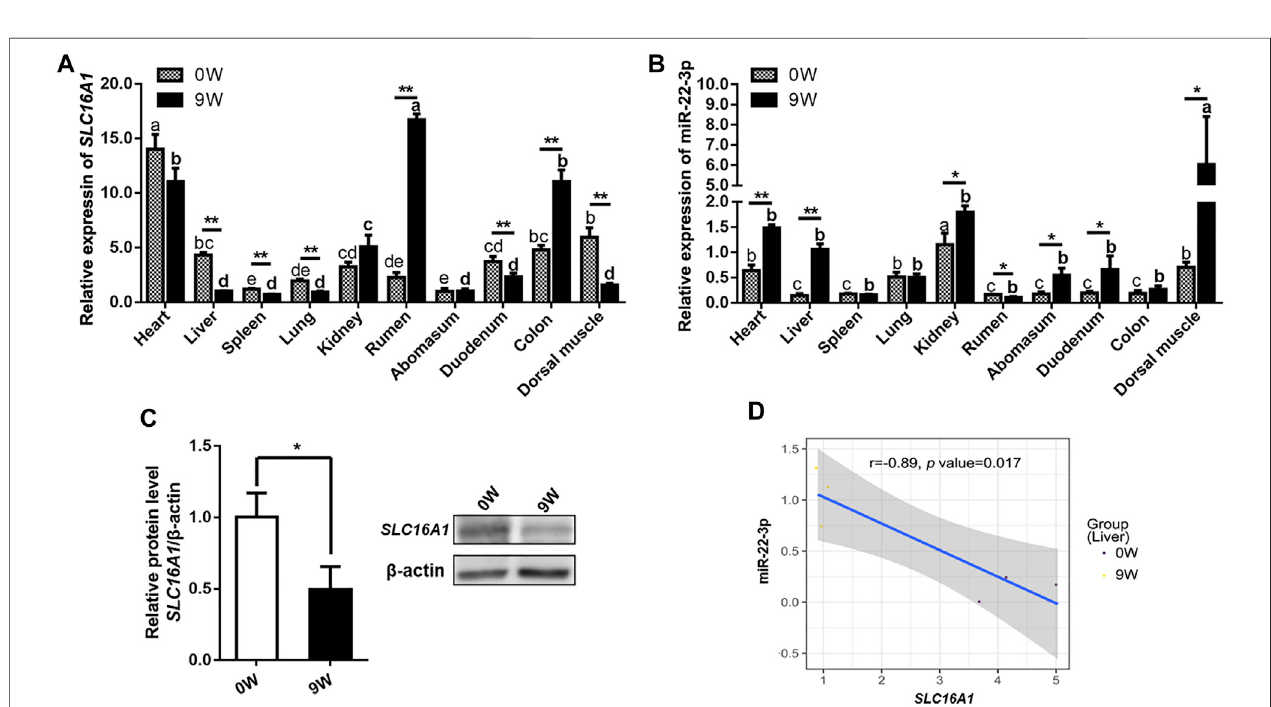
FIGURE 5 | Validation of the expression patterns of bovine SLC16A1 and miR-22-3p. (A) Relative expression of SLC16A1 and (B) miR-22-3p in ten investigated tissuesfrom0Wand 9Wcalves. (C) Relativeexpressionof SLC16A1 inbovinelivertissuesdetermined bywesternblotting. (D) Pearsoncorrelationanalysisof SLC16A1 and miR-22-3p expression in bovine liver